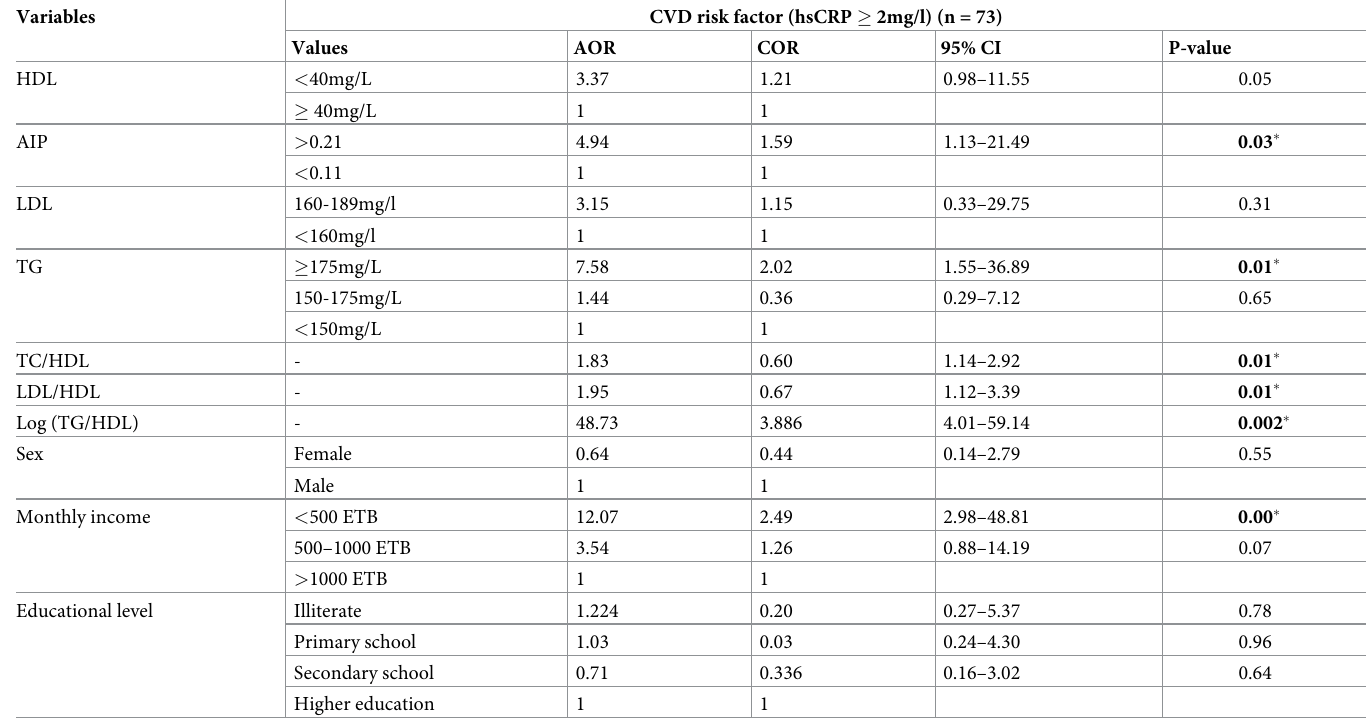
Table 4. Comparison of association of demographic and biochemical parameters with hsCRP.